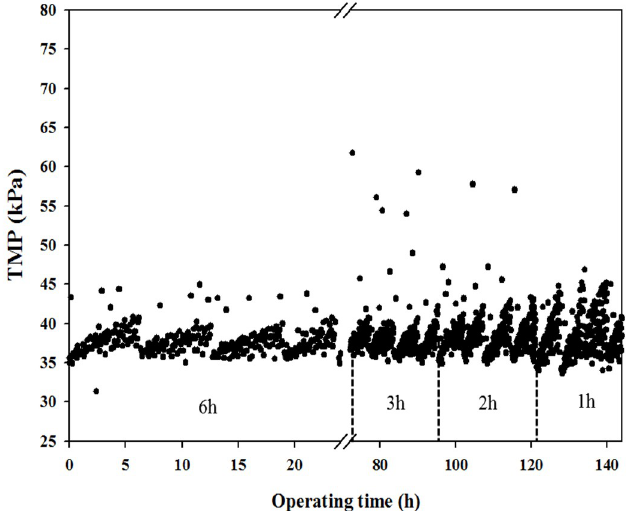
Figure 9. Changes in TMP based on changed injection time under Condition A of the in-line coagulation/UF membrane